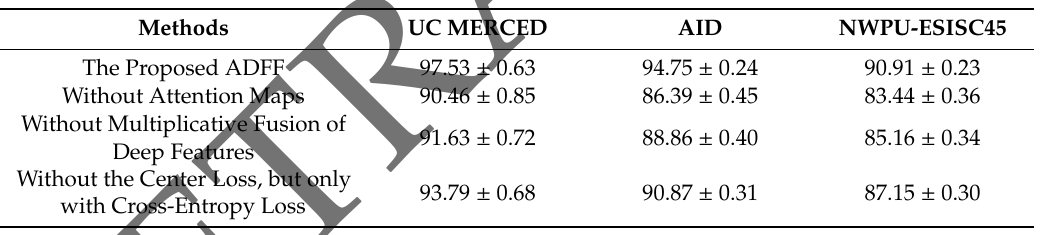
Table 6. Standard deviations and overall accuracy of approaches removing one part of the ADFF framework with a higher training